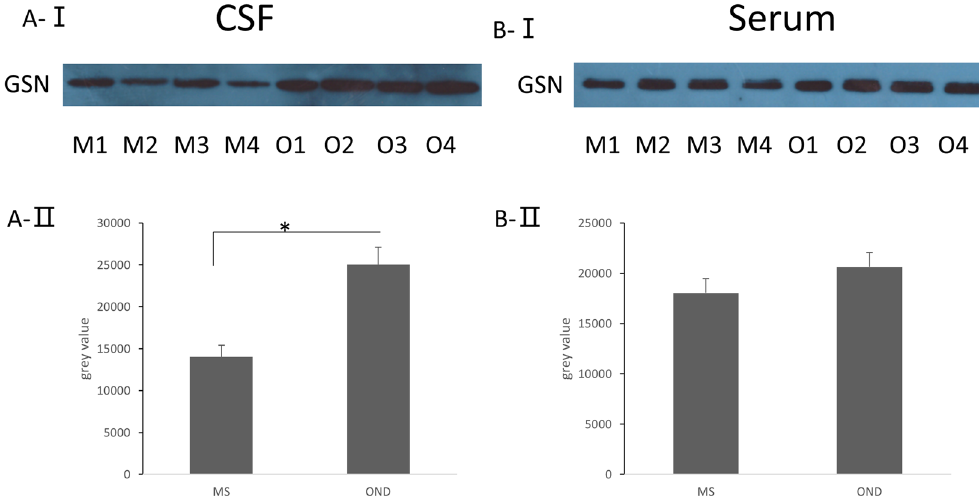
Figure 3. The expression of pGSN is decreased in the CSF, but only changed slightly in the serum of MS patients. A-I , Analysis of pGSN levels in the CSF of MS patients (M1-M4) or OND patients (O1-O4) by Western blot. A-II , We calculated the relative volume percentage of each band using Quantity One software. * p < 0.05 (one-way ANOVA). B-I , Analysis of pGSN levels in the serum of MS patients (M1-M4) or OND patients (O1- O4) by Western blot. B-II , We calculated the relative volume percentage of each band using Quantity One